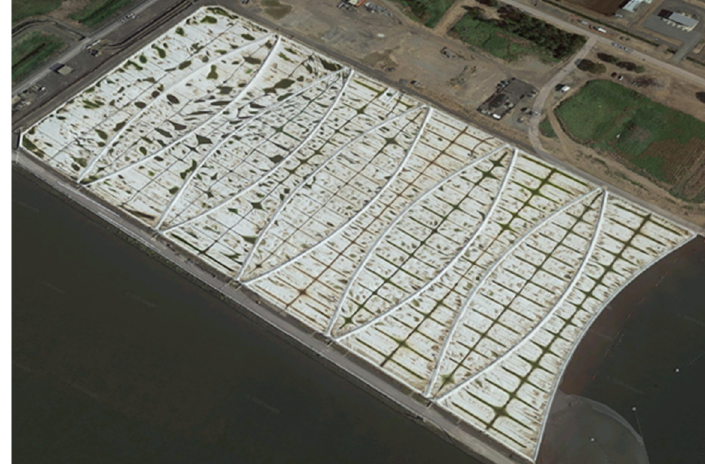
Figure 1. Illustration of HDPE floating cover in the WTP.